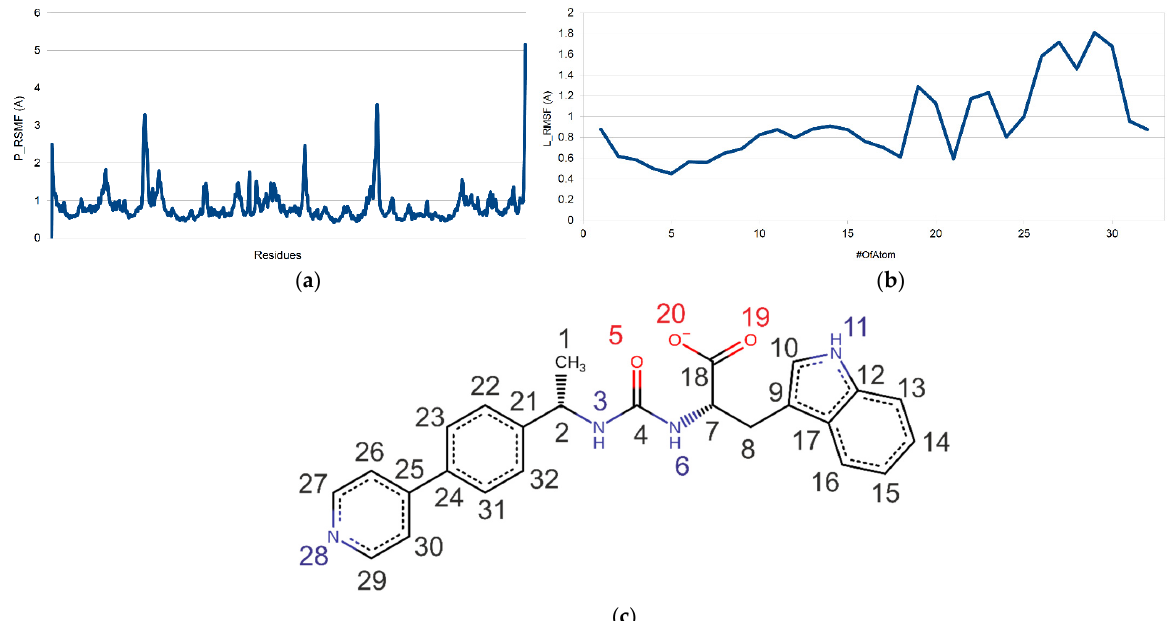
Figure 16. RSMF plots of ( a ) protein, ( b ) ligand Z3969355209 and ( c ) respective atomic enumeration in the ligand.